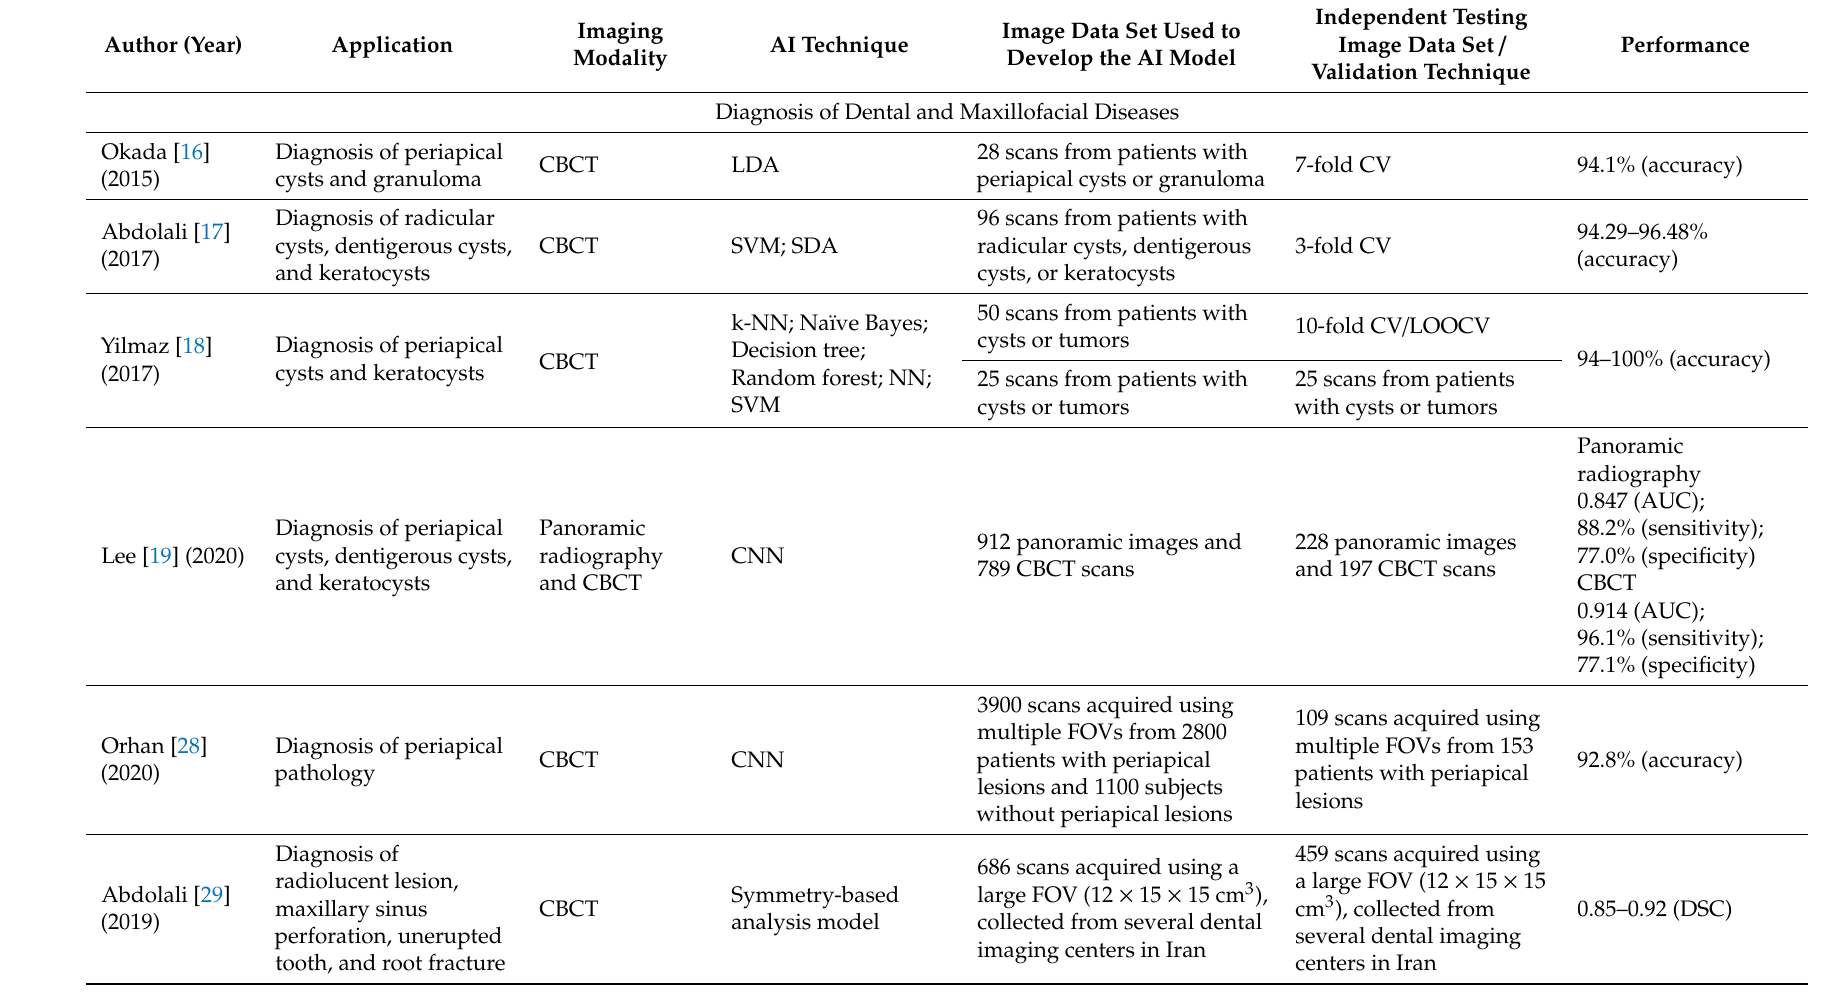
Table 1. Characteristics of studies describing machine learning-based artificial intelligence (AI) models applied in dentomaxillofacial radiology